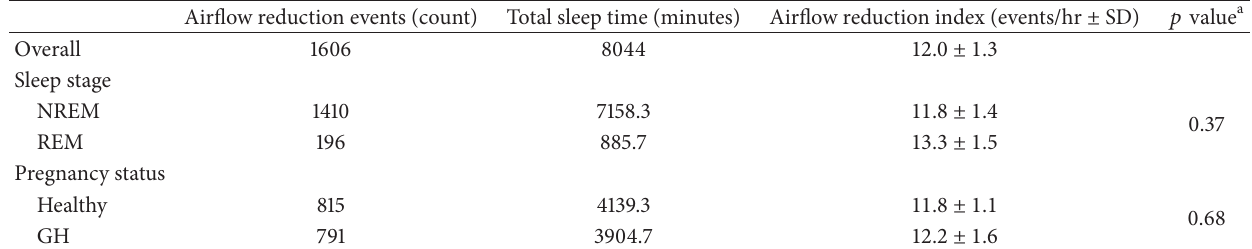
Table 3: Airflow reduction